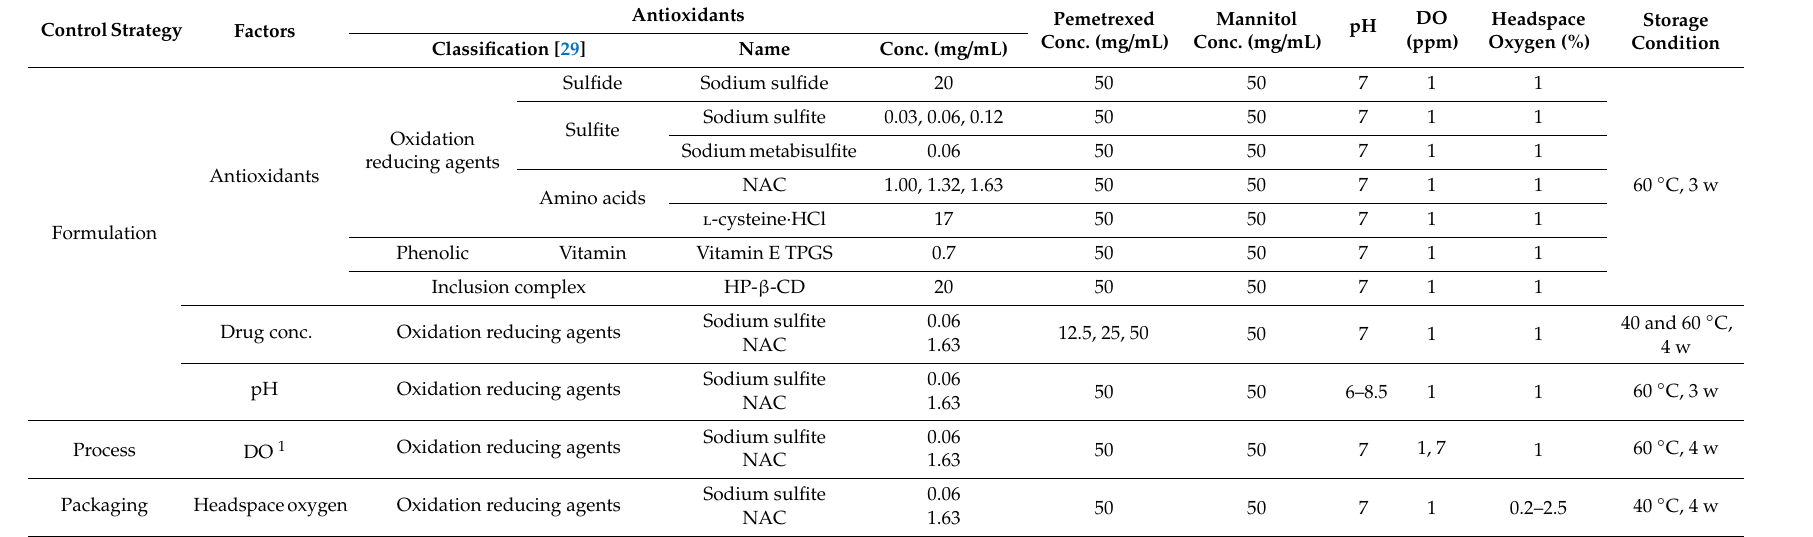
Table 2. Compositions of stability test sample